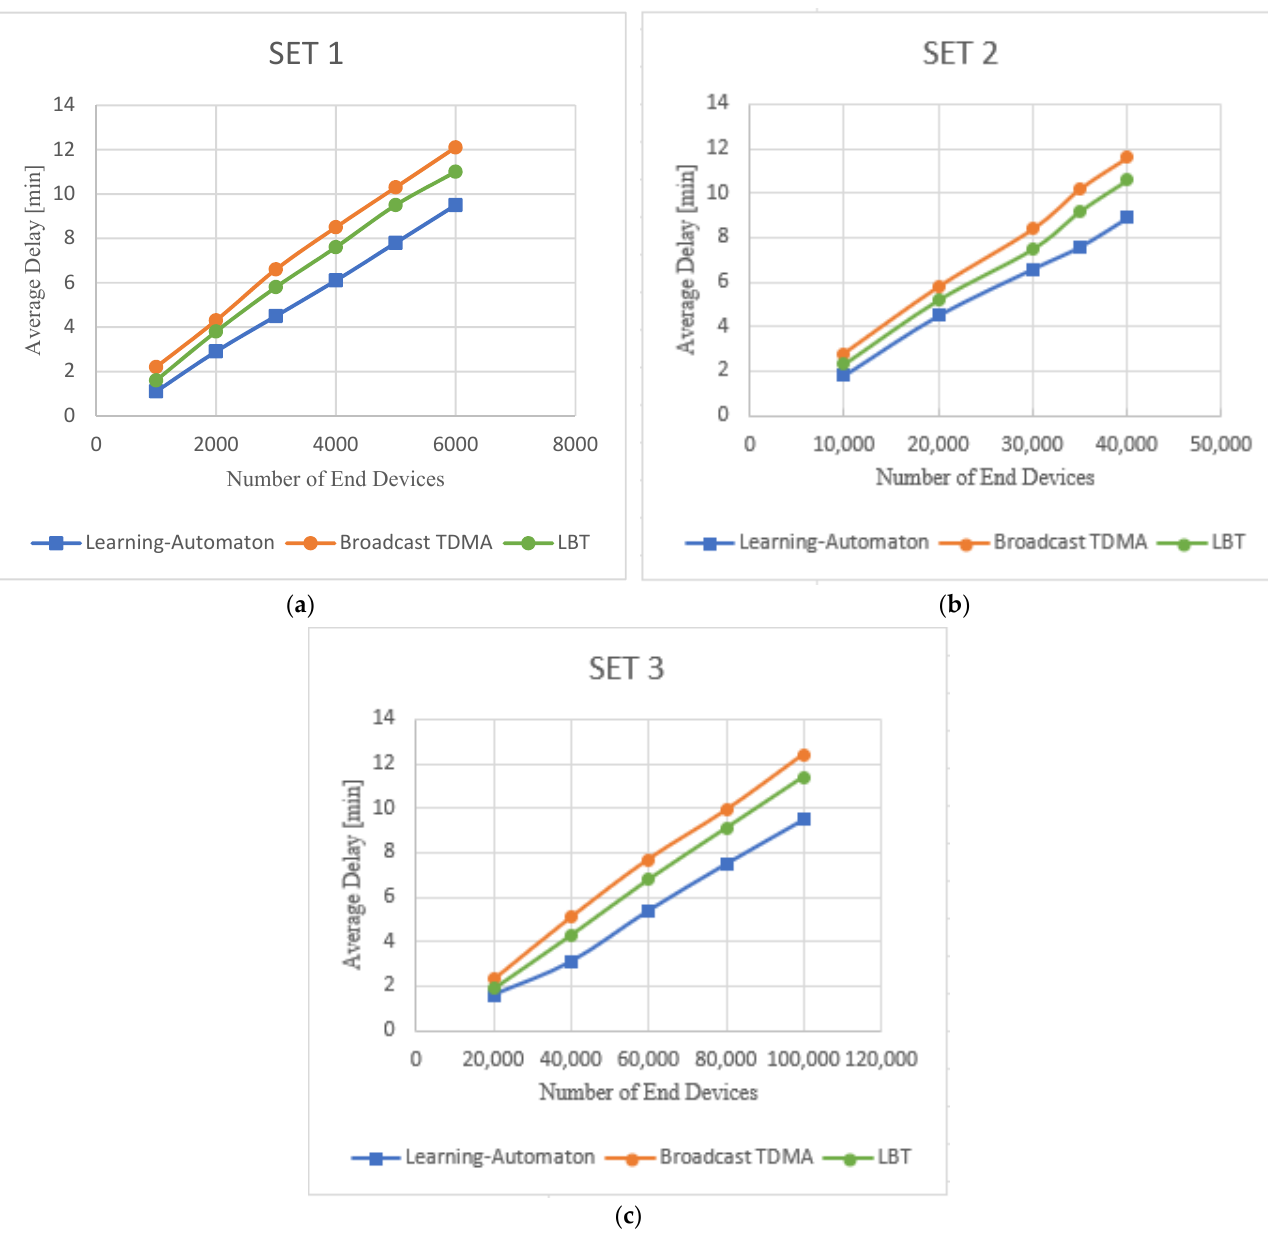
Figure 8. Average delay versus number of end devices for ( a ) SET1, ( b ) SET2 and ( c ) SET3.